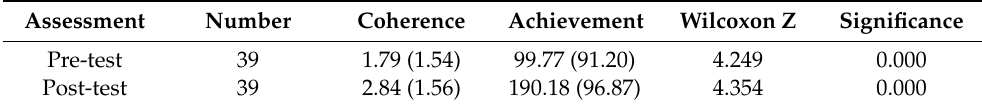
Table 1. Quantitative Process Evaluation of the IM